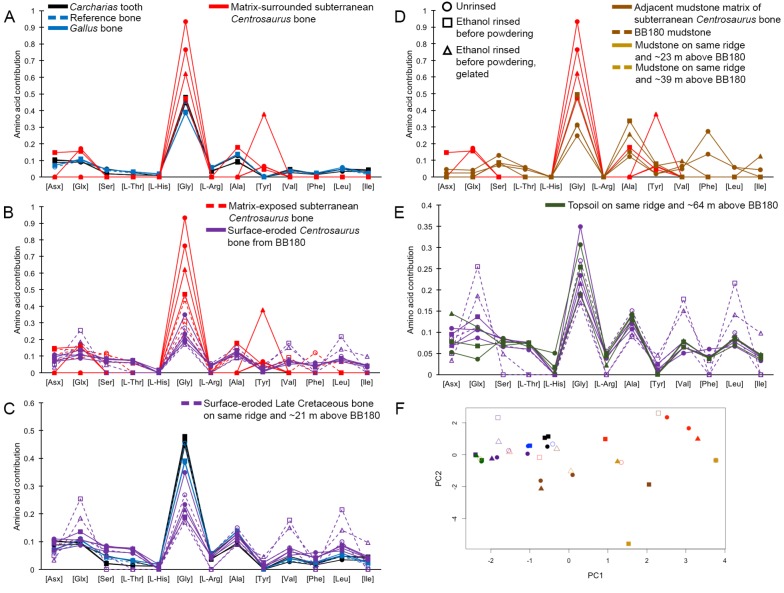
THAA compositional profiles of the samples based on amino acid percentages.(A) Late Cretaceous subterranean bone (red) compared to non-aseptically collected Pleistocene-Holocene teeth (black) and modern bone (blue). (B) Late Cretaceous subterranean bone (red) compared to surface-eroded Late Cretaceous bone from the same outcrop (purple). (C) Surface-eroded Late Cretaceous bone (purple) compared to Pleistocene-Holocene teeth (black) and modern bone (blue). (D) Late Cretaceous subterranean bone aseptically collected (red) compared to the adjacent mudstone matrix (brown). (E) Surface-eroded Late Cretaceous bone (purple) compared to topsoil at higher elevation (i.e., prairie level) on the same ridge (green). (F) PCA on normalised amino acid percentages (see A–E legends). See Appendix 1 (Appendix 1—figure 25; Appendix 1—table 11) for PCA summary. Color and symbol coding is constant throughout.